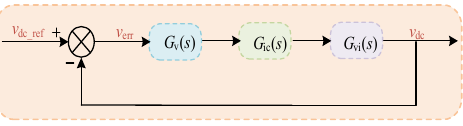
Figure 12. Voltage outer loop controller structure.